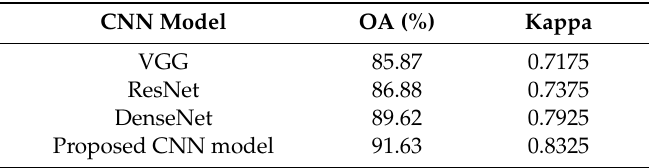
Table 5. Comparison with classical CNN models.